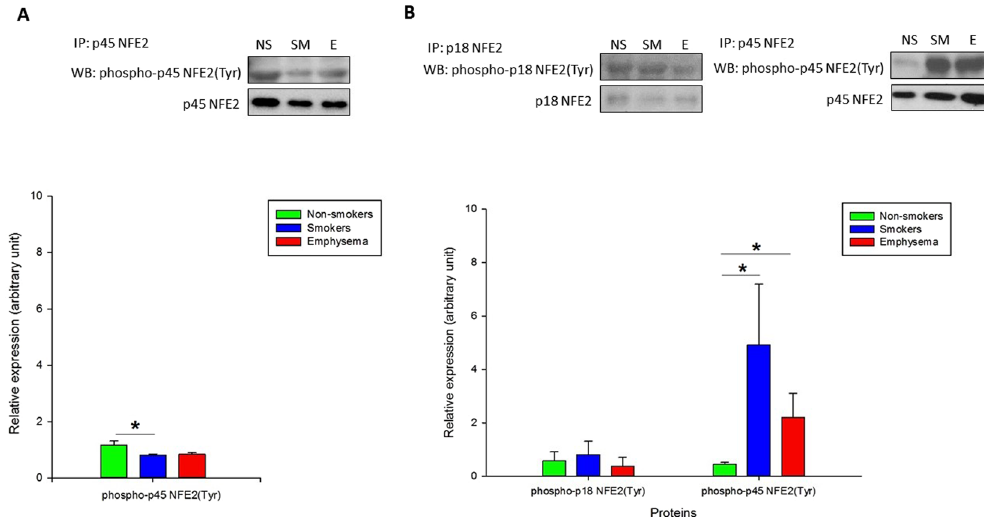
Figure 2. p45 NFE2 and p18 NFE2 tyrosine phosphorylation in human ATII cells and lung tissue obtained from control non-smokers (NS) and smokers (SM) and patients with emphysema (E). Immunoprecipitation was performed in freshly isolated ATII cells ( A ) and lung tissue ( B ) followed by Western blotting analysis. Densitometric quantification is also shown. * Statistically significant difference ( p < 0.05). Data are shown as the mean ( ± s.e.m.).